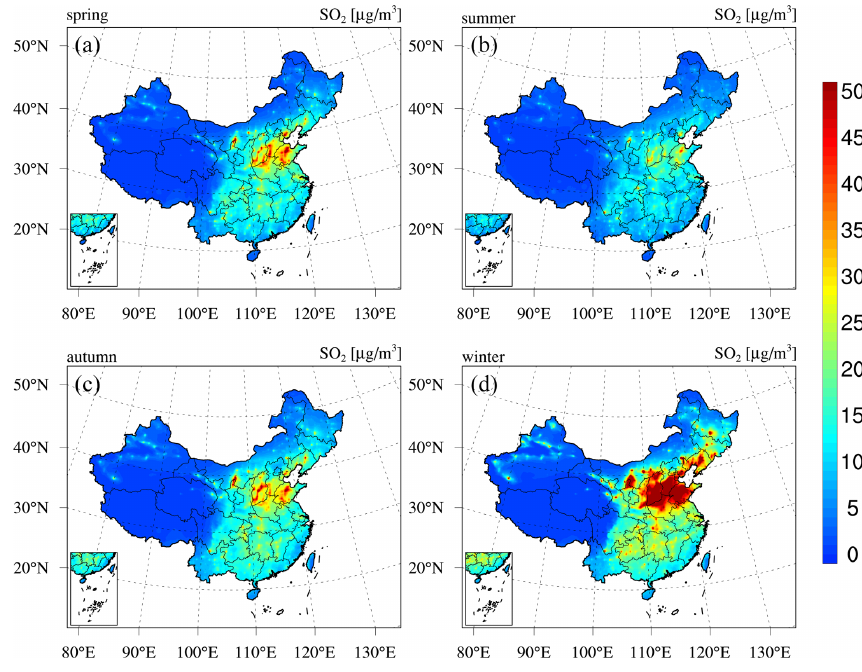
Figure D3. Same as Fig. D1 but for SO 2 .